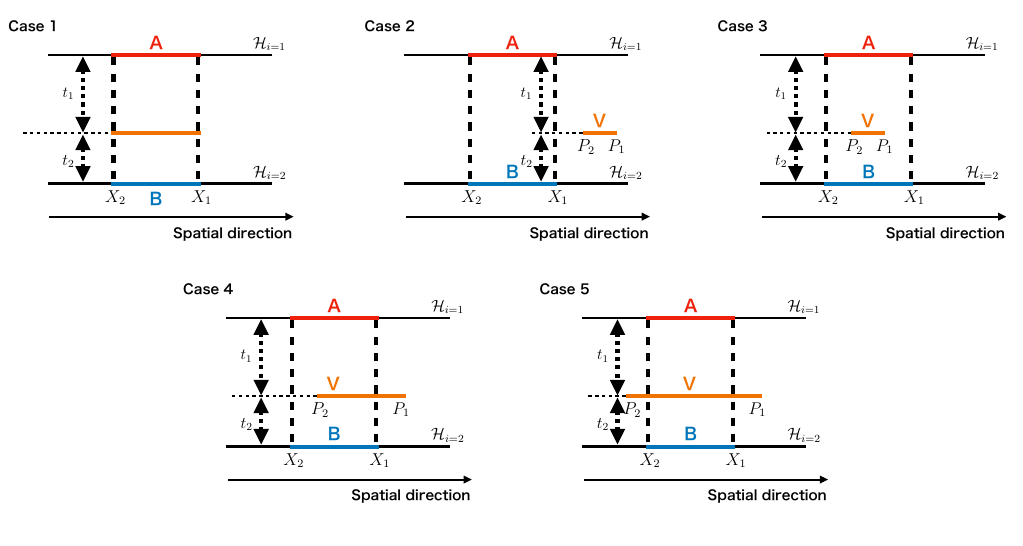
Figure 3: A cartoon of the trajectory of the operator. Orange dashed and dotted arrows illustrate the trajectory in t 2 of the operators, while the purple dashed and dotted arrows illustrate that the trajectory in t 1 . In the limits where t 1 approach 0 or ⇡ .